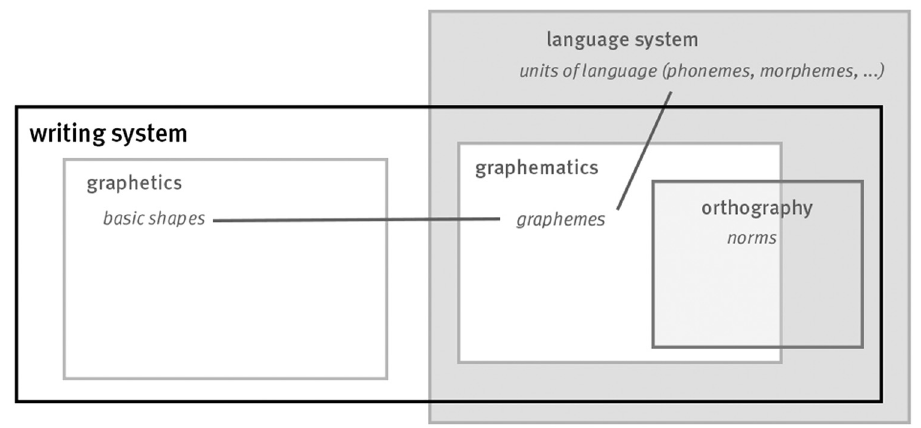
Figure 1: Multimodular model of writing